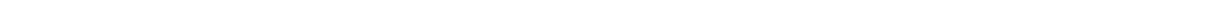
Figure 1 - Leukometry and differential leukogram with the percentage of circulating neutrophils, lymphocytes and monocytes. A, macrophage study. B, neutrophil study. The results are expressed as the average number of leukocytes and the percentage of cells ¡ standard error of the average. *, p # 0.05 for exercise groups submitted to low- and moderate-intensity exercise (unadapted low intensity = EXAGL; moderate intensity = EXAGM and corresponding preadapted groups, EXADL and EXADM) as compared to the control group (C); # p # 0.05 for comparisons among the groups; ## p # 0.05 for comparisons made between the macrophage and neutrophil study